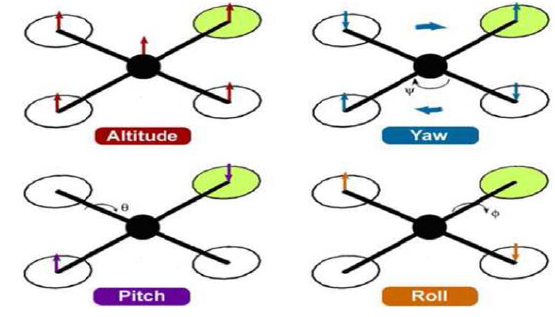
Figure 1. Quad rotor dynamics